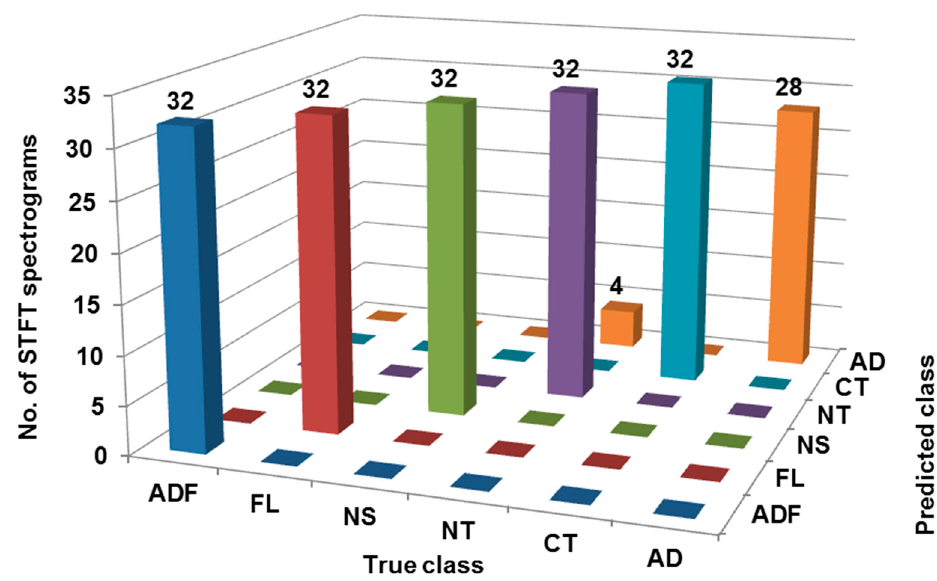
Figure 7. Confusion matrix considering training dataset.